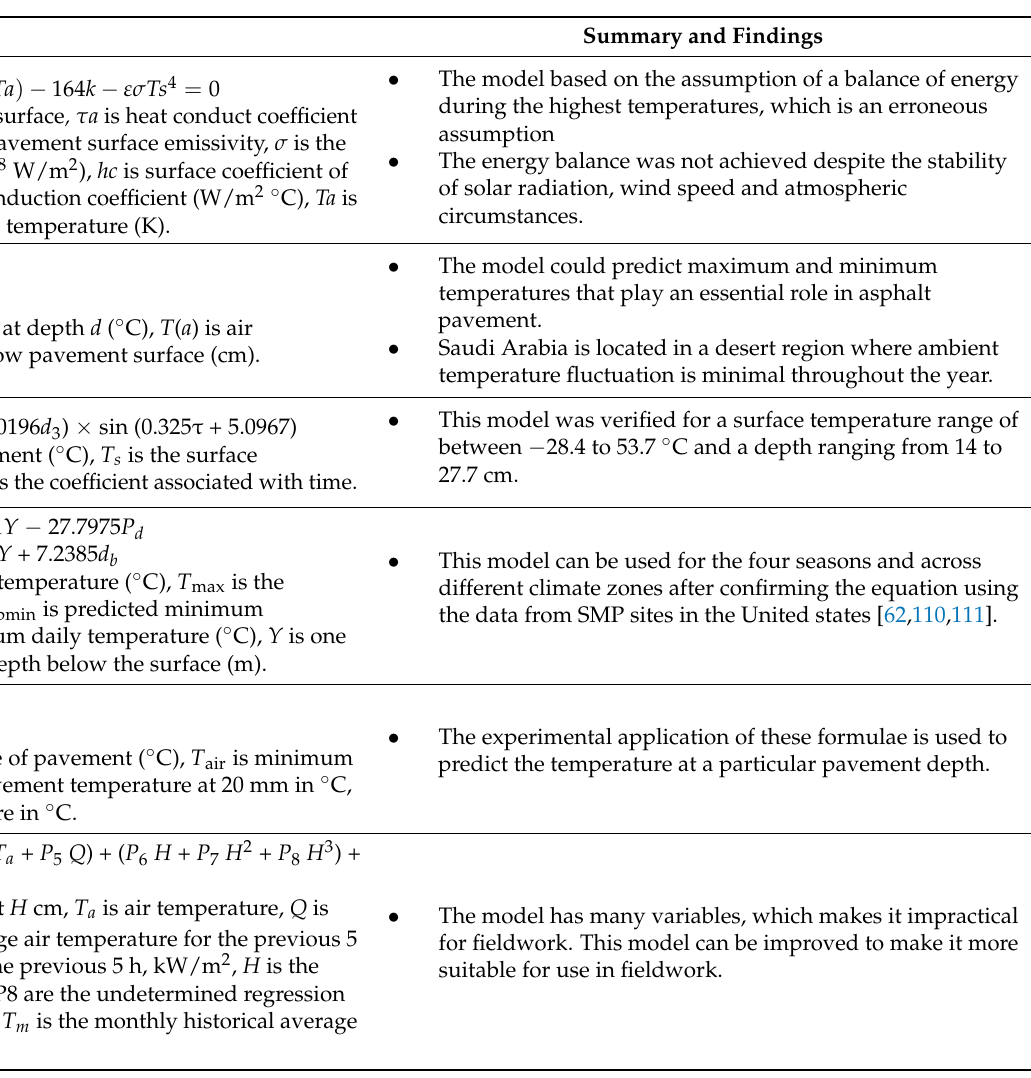
Table 3. Pavement temperature prediction models using statistical